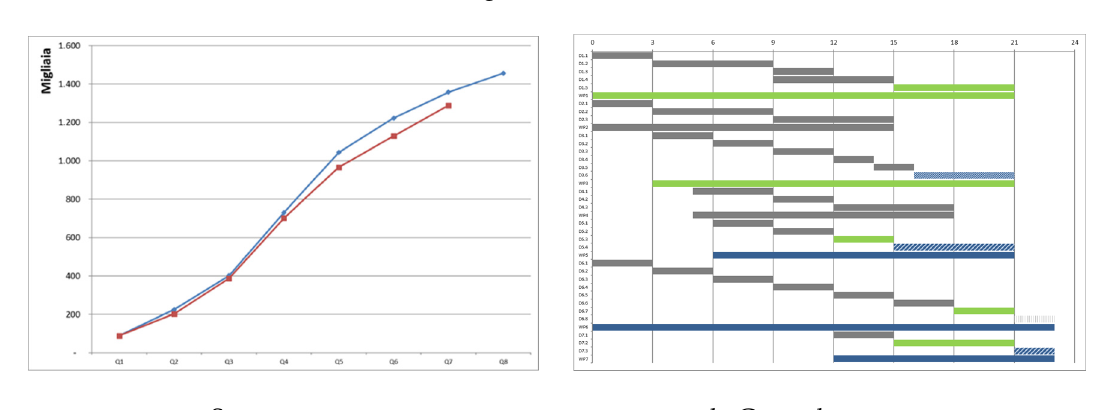
J. Open Innov. Technol. Mark. Complex. 2020 , 6 , 15